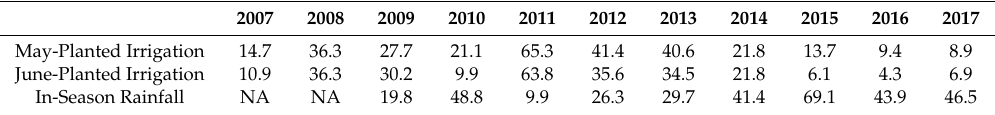
Table 3. Total irrigation (cm) applied to May and June-planted variety trials during each year, and total in-season rainfall at the Lubbock AgriLife research